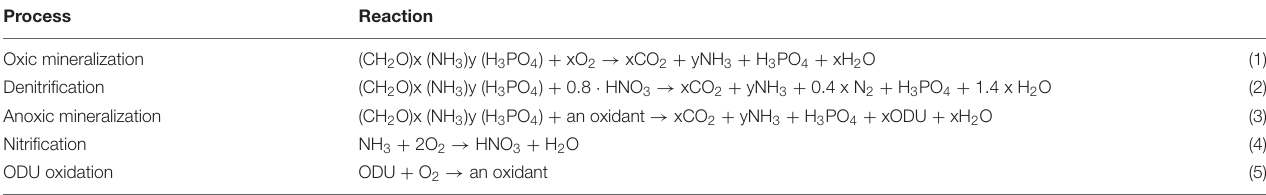
TABLE 1 | Diagenetic reactions used in OMEXDIA.